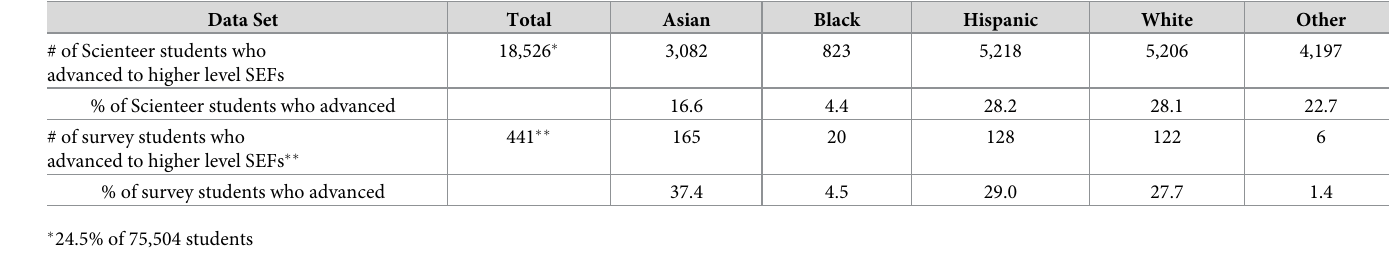
Table 2. Distribution by ethnicity of 2018/19 and 2019/20 Scienteer and survey students who competed in higher level SEFs (district, region, or state). Data Set Total Asian Black Hispanic White Other 18,526